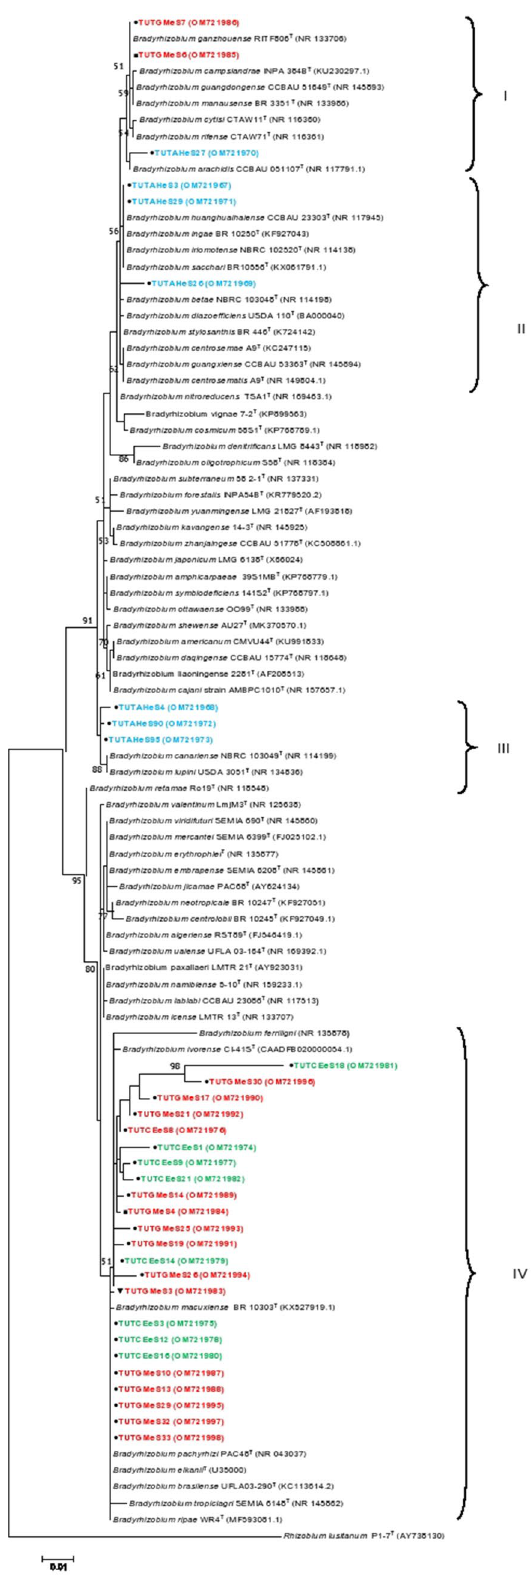
Figure 3. Maximum likelihood phylogeny of rhizobial symbionts of groundnut, jack bean and soybean from various locations in Eswatini based on 16S rRNA gene sequences. For each isolate, the location of origin is indicated by assigning different symbols, e.g., circle-Malkerns Research station, square-New Heaven and triangle-Luve. GenBank accession numbers are indicated in parenthesis after the name of each isolate. Isolates’ names are colour coded based on the host species as Blue-groundnut, Green-jack bean and